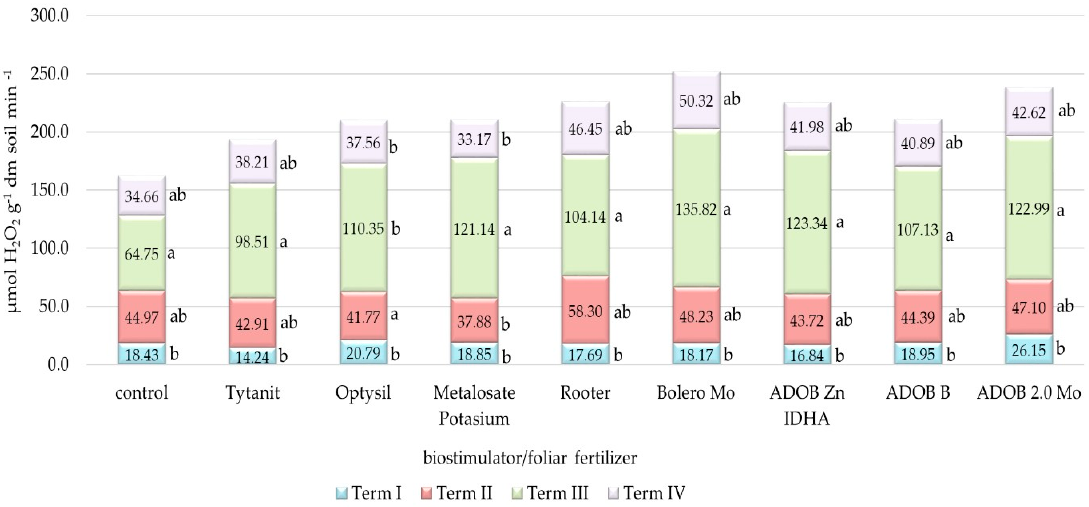
Figure 7. The influence of the bio-stimulants and fertilizers on the catalase activity. Abbreviation: a, b—homogenous groups according to Duncan’s test at level p = 0.05; I term—at the plants’ emergence (BBCH 5–10), II term—at the plants’ full growth (BBCH 35–40), III term—at the at the plants’ florescence (BBCH 51–59), IV term—after harvest.